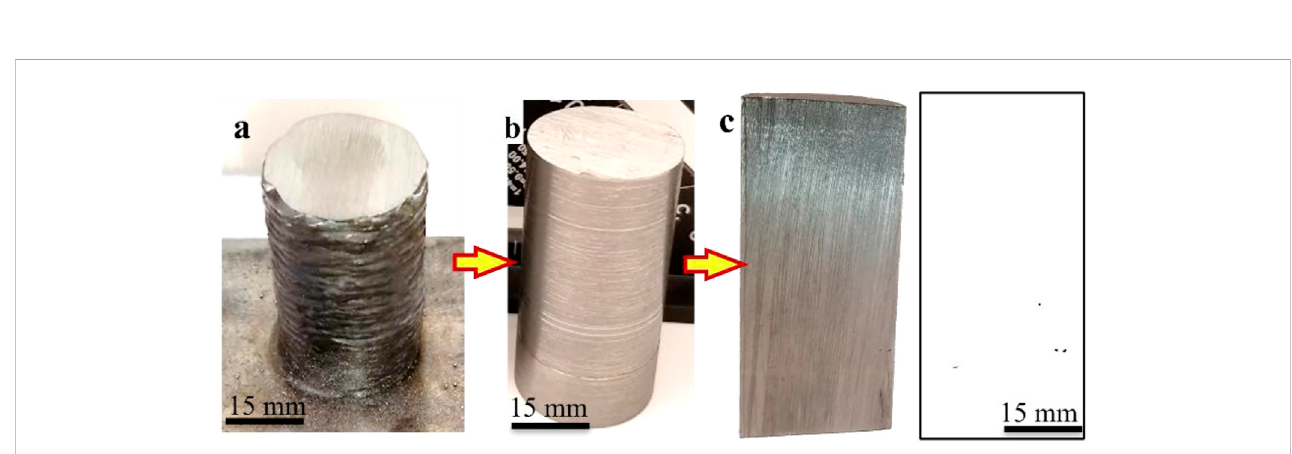
FIGURE 5 (A) WAAM printed cylinder with active cooling; (B) cylinder after the turning operation; (C) after longitudinal sectioning. Binary image displays reduced pore